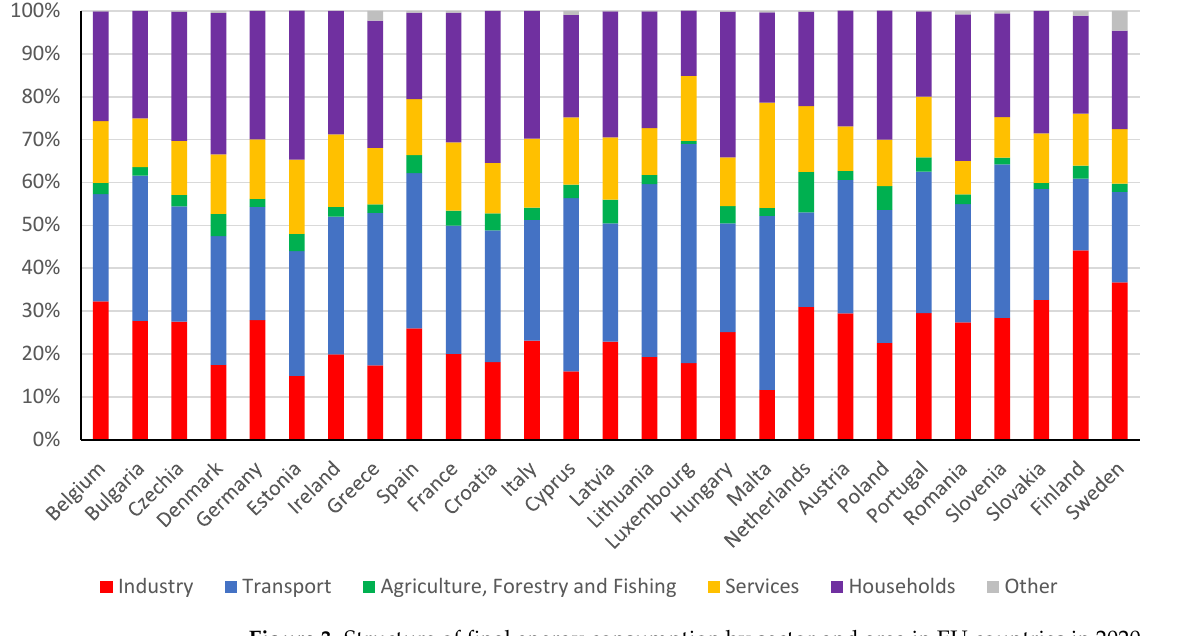
Figure 3. Structure of final energy consumption by sector and area in EU countries in 2020.